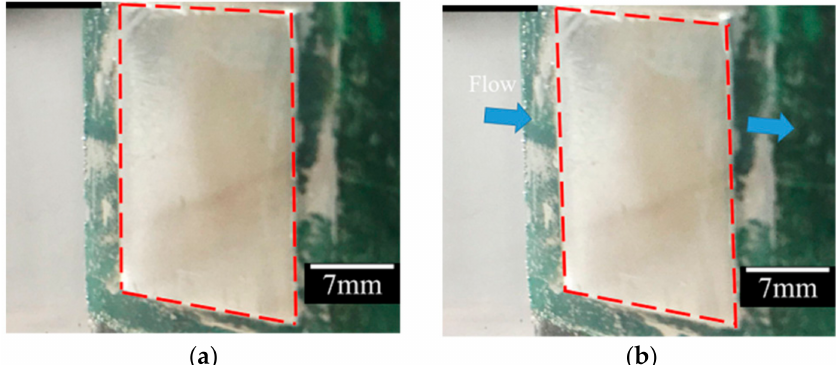
Figure 8. Measurement of underwater air-retentivity of the nanowired Teflon FEP superhydrophobic surface in a turbulent flow: ( a ) before flow; ( b ) after 6.5 h of turbulent flow, where the flow direction was tangential to the nanowired Teflon FEP surface, as indicated by the arrows in the image. In each image, the dashed lines (red in color) represent the boundary of the specimen, whose inner area is fully covered by an air